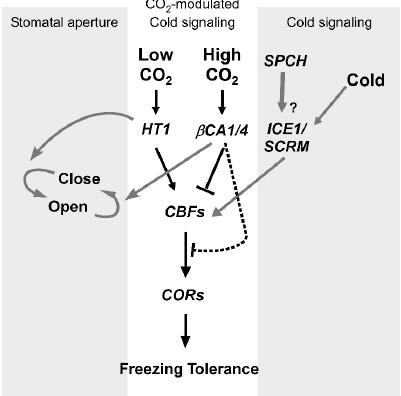
Figure 6. A schematic diagram for CO 2 -mediated CBF-dependent cold signaling and freezing tolerance in Arabidopsis. Black arrows indicate a proposed CO 2 modulated cold signaling pathway ( center ). Grey arrows represent signaling pathways involved in stomatal movement ( left ) and freezing tolerance ( right ). This model proposes that CO 2 -modulated CBF-dependent cold signaling is mediated by β CA1/4 and HT1. In response to supra-ambient CO 2 , β CA1/4 suppresses HT1, which decreases both CBF-mediated cold signaling and freezing tolerance, while suppression of HT1 by β CA1/4 is reduced in response to sub-ambient CO 2 , and this enhances CBF-mediated freezing tolerance. In addition, β CA1/4 mediate suppression of CBF-independent expression of downstream cold-responsive genes. A potential new connection based on our preliminary results is shown as a dotted line. The question mark indicates that the gene responsible for the indicated pathway has not yet been definitely identified.